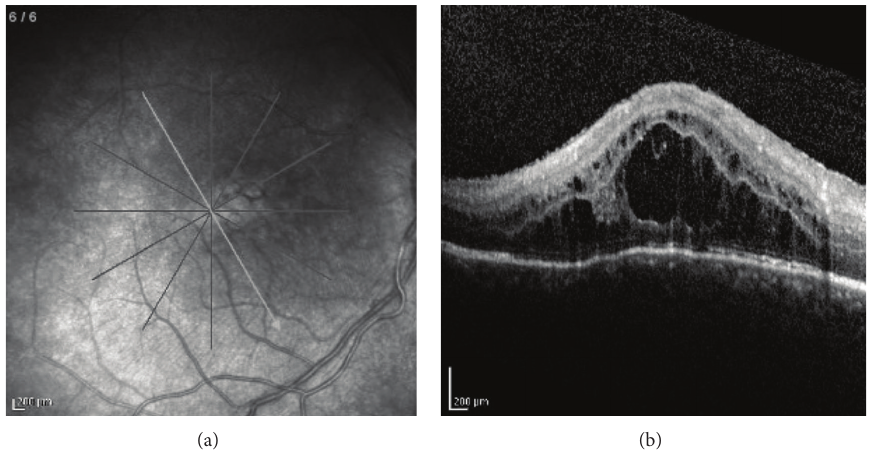
Figure 2: Patient no. 3: right eye. Scanning laser ophthalmoscope fundus image (on the left) showing the position of optical coherence tomography (OCT) section. Spectralis OCT (on the right) shows severe macular edema (foveal thickness 947 𝜇 m).